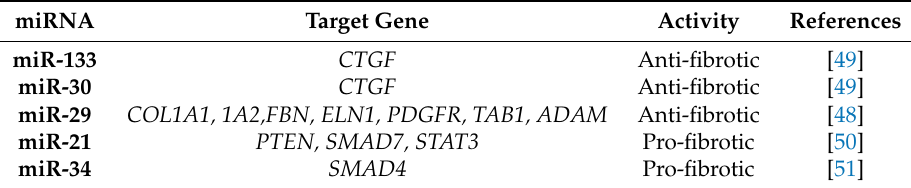
Table 1. miRNAs involved in the mechano-regulation of cardiac fibrosis. miRNA Target Gene